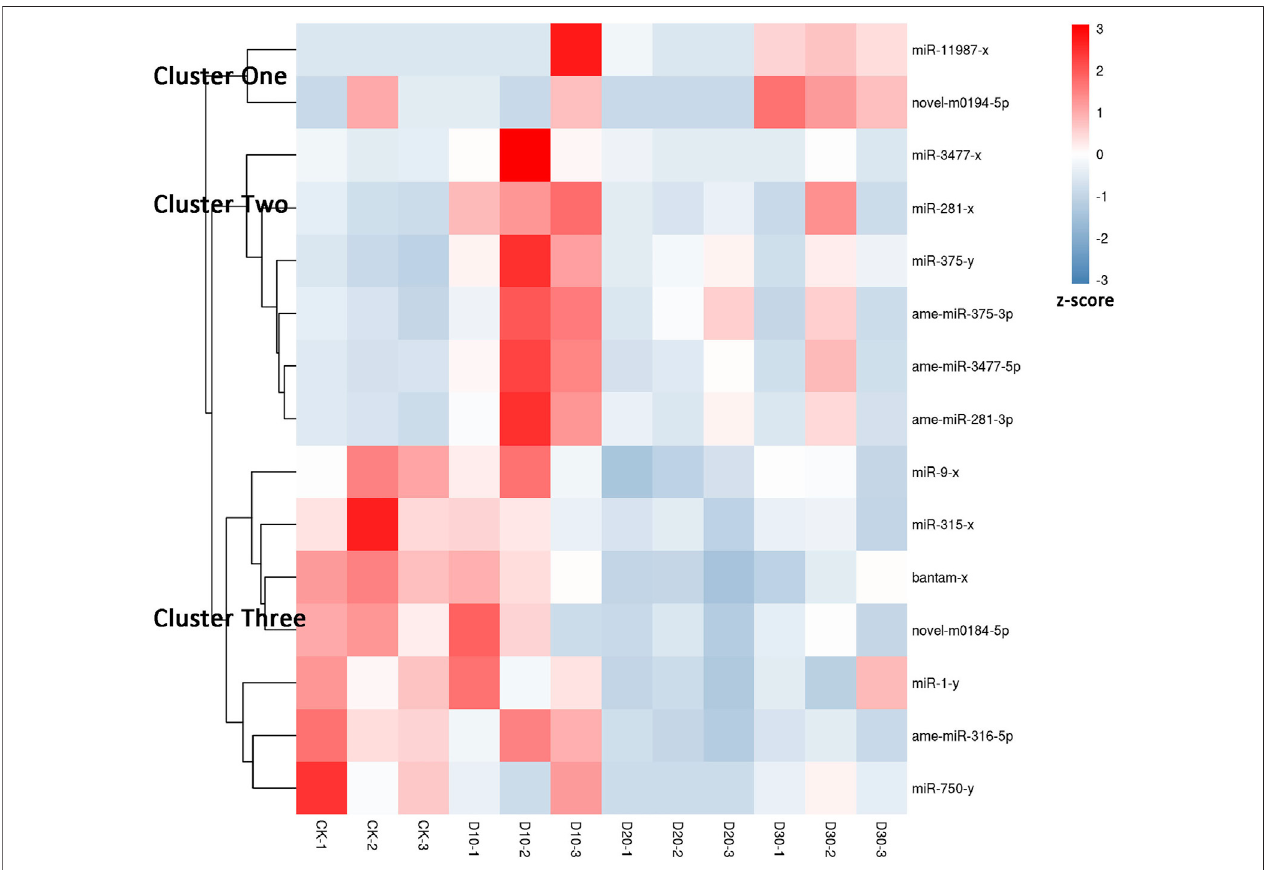
FIGURE 1 | Expression pattern cluster analysis of differential expressed miRNAs. Each column represents a sample, and each row represents a miRNA. The expression level of miRNA in different samples is indicated by different colors. The redder the color, the higher the expression level, and the bluer the color, the lower the expression